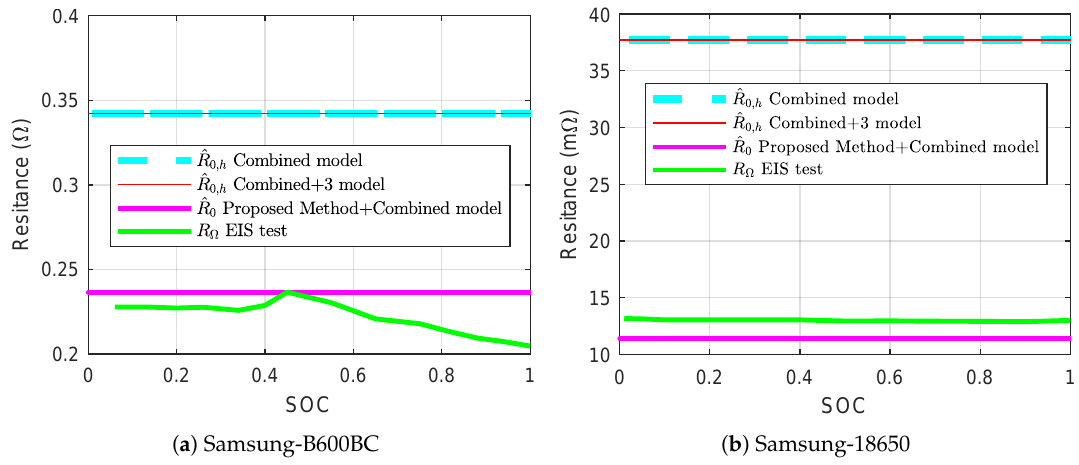
Figure 13. Identified internal resistances from different